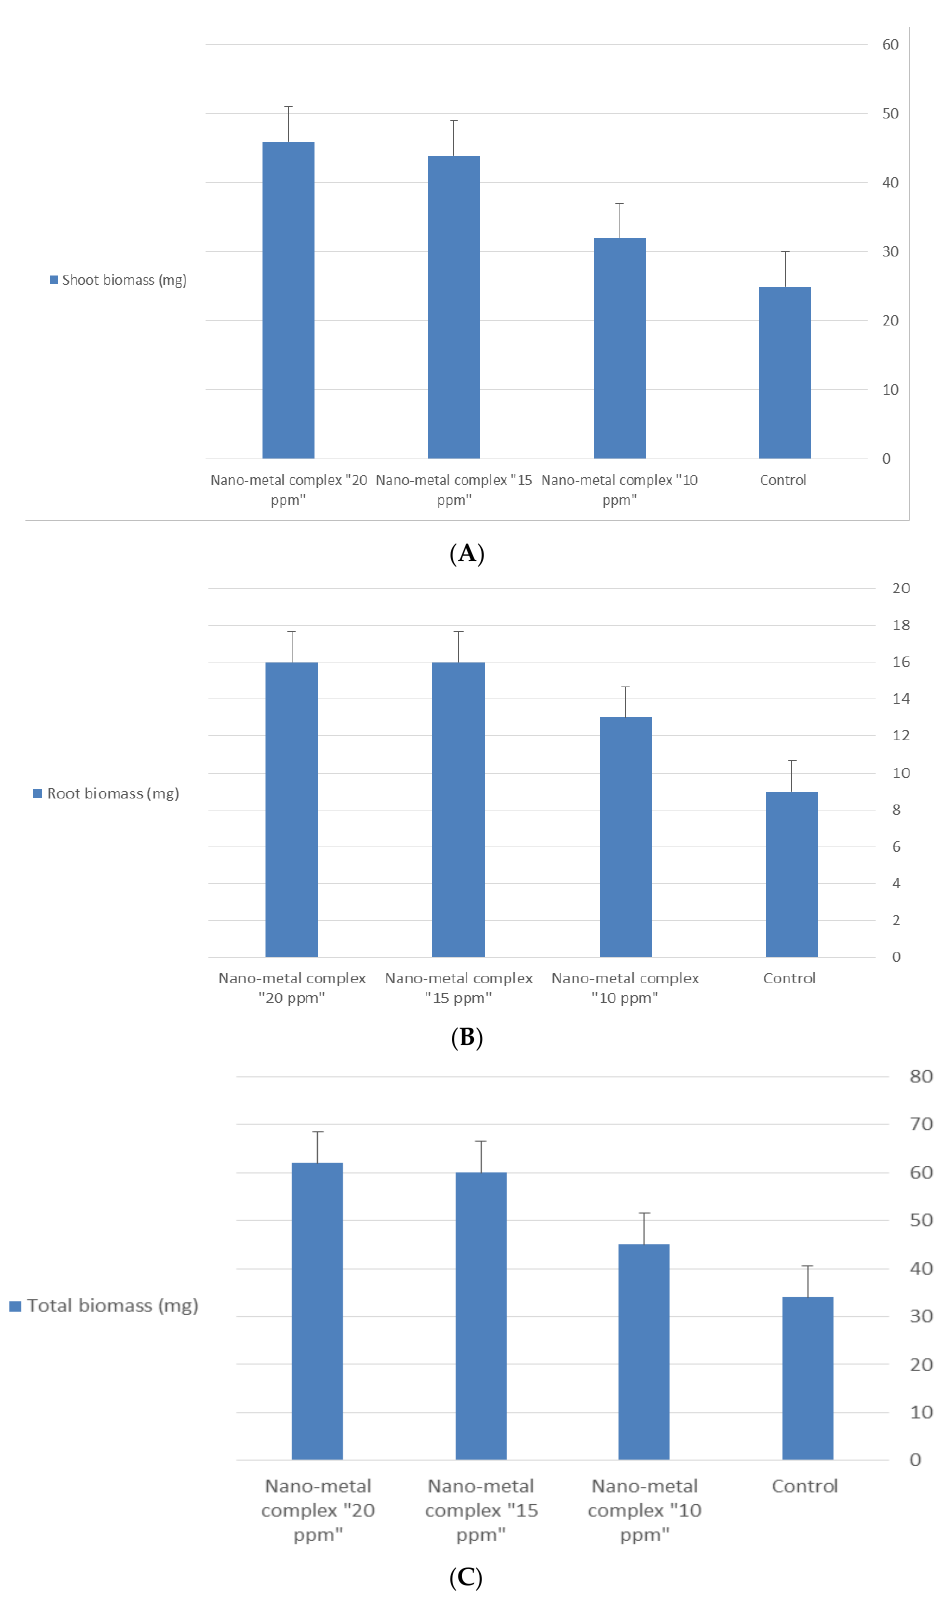
Figure 9. Effect of nano-metal complex on Vicia faba plant biomass after 4 weeks of planting. ( A ) Shoot biomass; ( B ) root biomass; ( C ) total biomass.